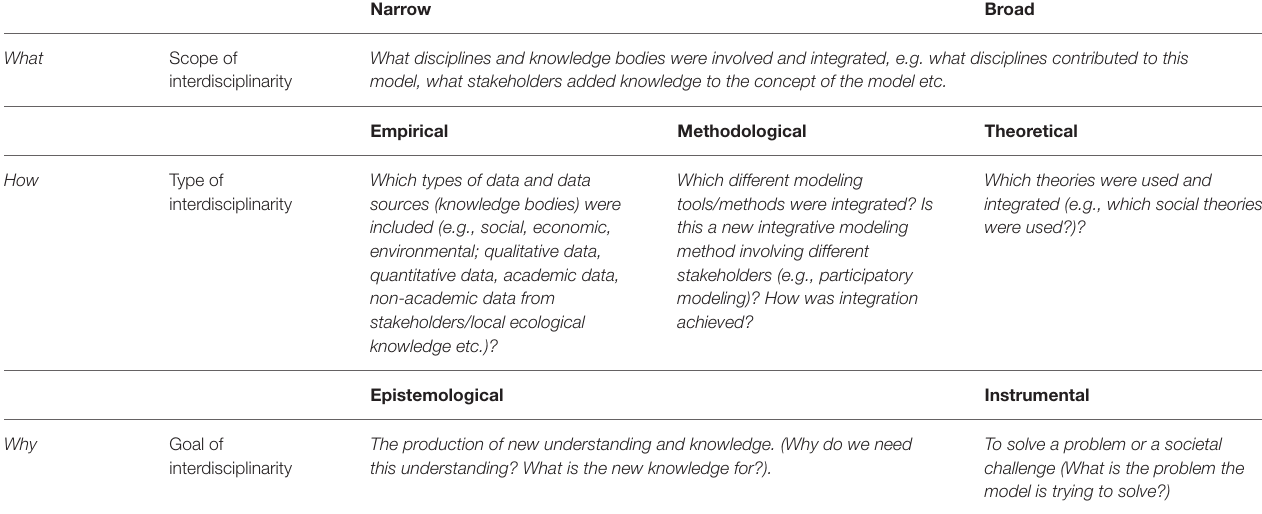
TABLE 5 | An overview of the protocol for assessing the interdisciplinarity of models, based on Huutoniemi et al.